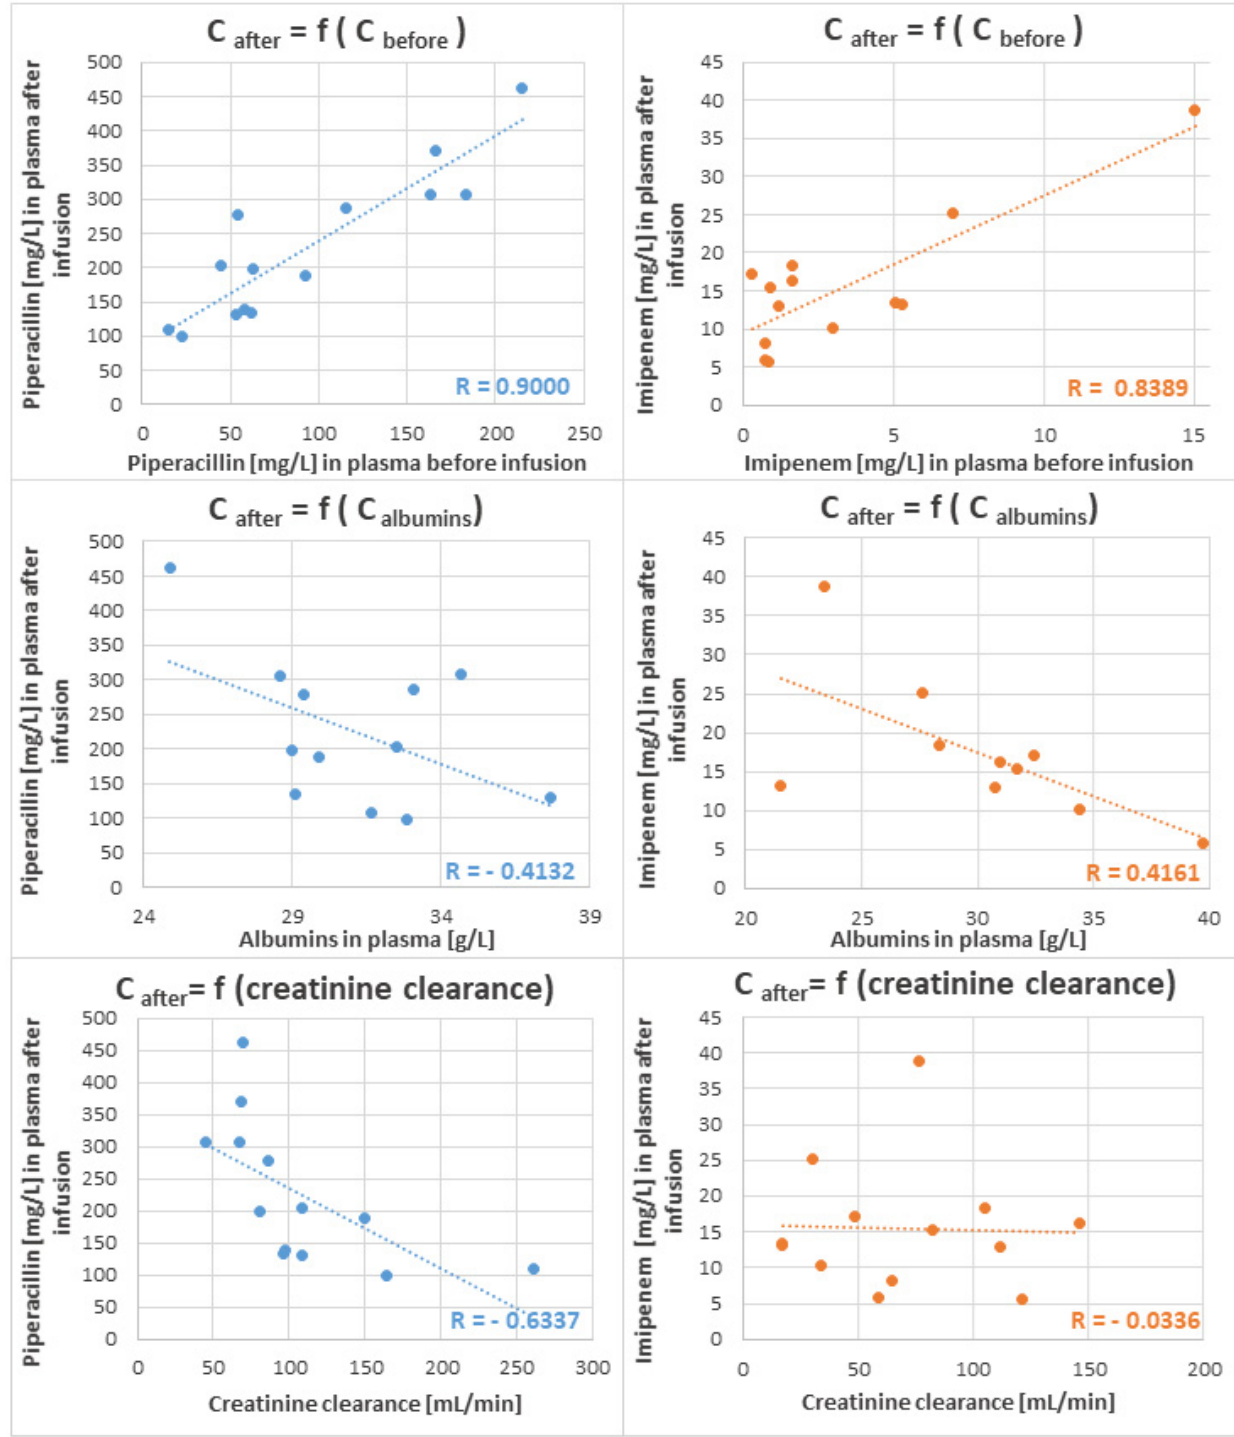
Figure 5. Concentrations [mg/L] of piperacillin (blue, left panel) and imipenem (orange, right panel) in plasma samples collected 1 h after the end of intravenous infusion in the function of antibiotic base-level before infusion (upper panel), albumins [g/L] in plasma (middle panel) and creatinine [mmol/L] in plasma (bottom panel). Tentative linear regression is given as a dotted line along with the respective value of the Pearson Correlation Coefficient.